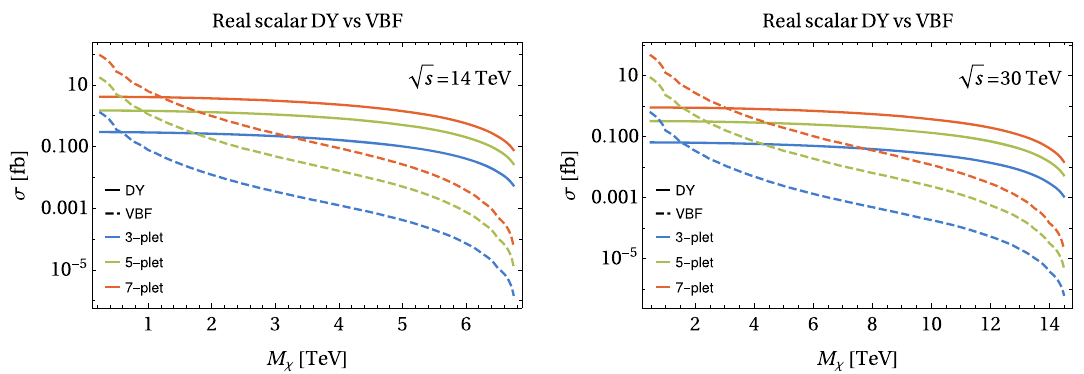
√ s = 14TeV. Right: scalar 5-plet